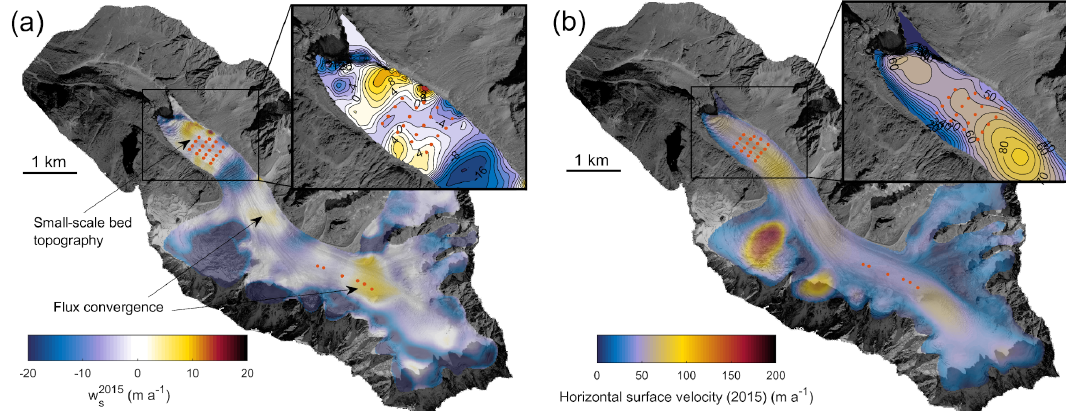
Figure 13. Vertical (a) and horizontal (b) surface velocities modelled at Argentière Glacier in 2015. Red dots show the locations of the ablation stakes set up at 2400 and 2650ma.s.l.